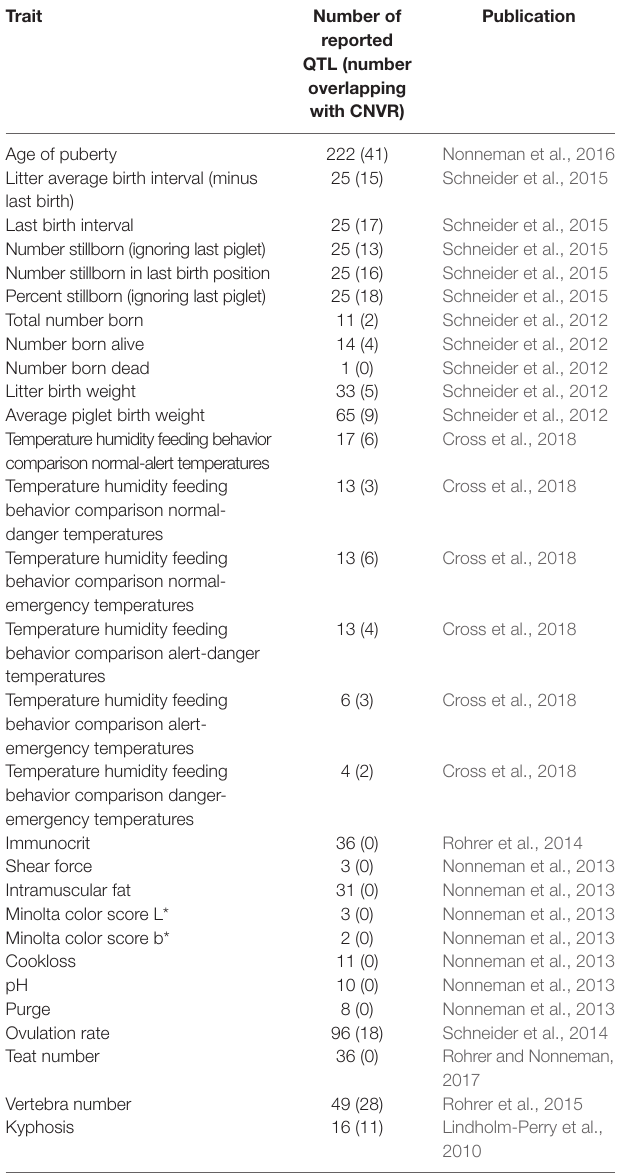
TABLE 4 | QTL identified in USMARC swine population from previously published